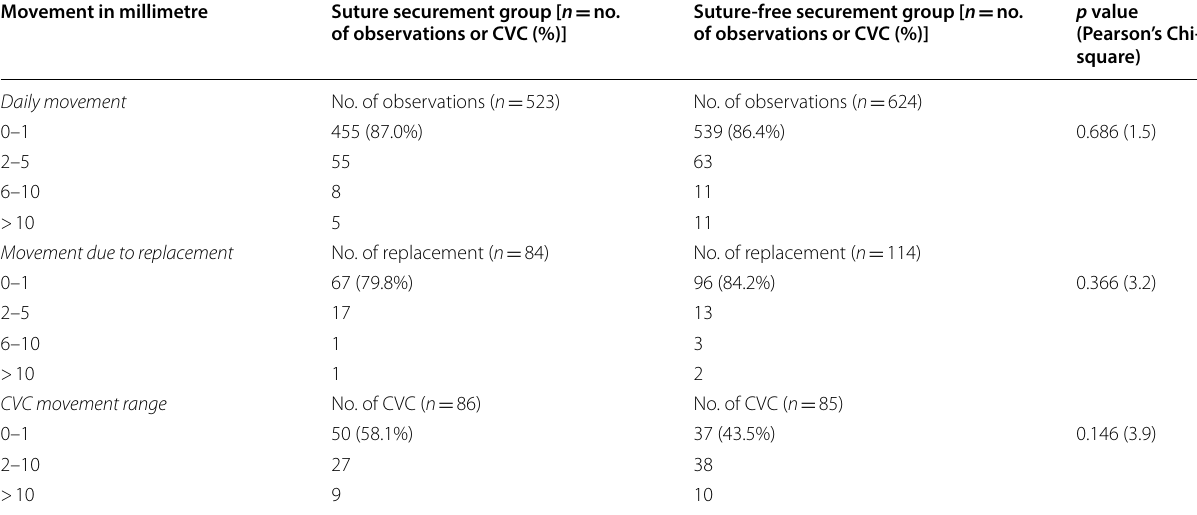
Table 3 Migration of short-term central venous catheters (CVCs) when secured with sutures and a Tegaderm ™ IV Advanced dressing (suture group) or 3M ™ PICC/CVC Securement Device group) [ n number of observations or CVC =